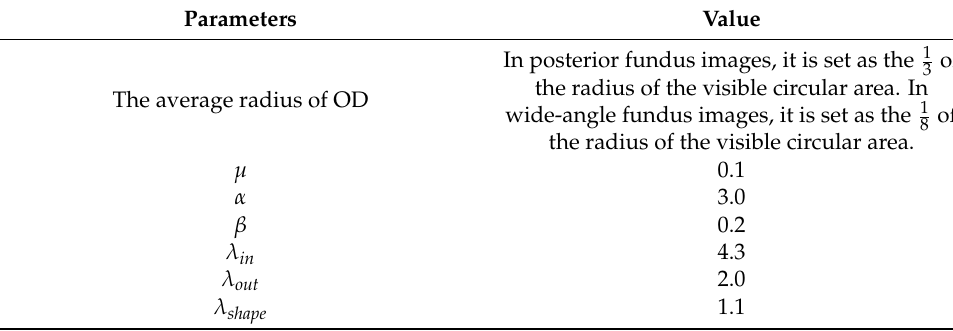
Table 3. Parameters used in multiple preprocessing